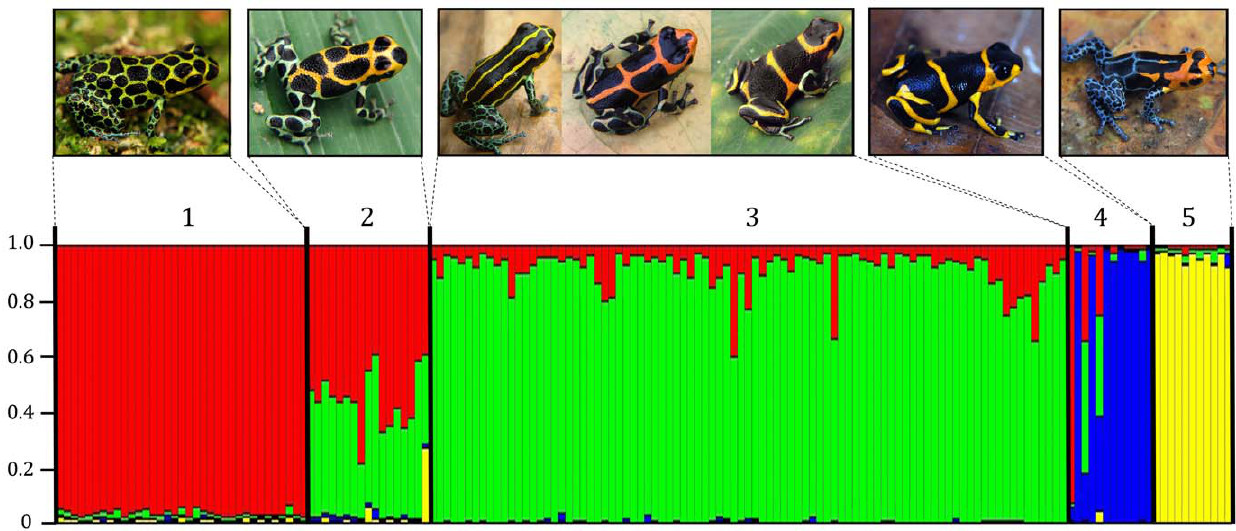
Figure 4. Genetic structure as inferred with the program STRUCTURE (K=4). Different colors represent inferred multilocus genotypes (see text). Clusters are as follows: 1) Chumia/Shapaja/Tarapoto/Cainarachi Valley, 2) Chazuta, 3) Chipaota/Curiyacu/Callanayacu/Ricardo Palma/ Achinamisa/Aguas Termales, 4) Sauce, 5) Varadero. Each individual frog is represented by a vertical line, which is partitioned into K + 1 segments, with each color representing the individual’s membership coefficient to that group. Chazuta is presented as a separate population in this figure, as it shows a clearly intermediate genotype, but in the optimal grouping derived from STRUCTURE Chazuta is part of cluster 1 (Chumia/Shapaja/Tarapoto/ Cainarachi Valley).